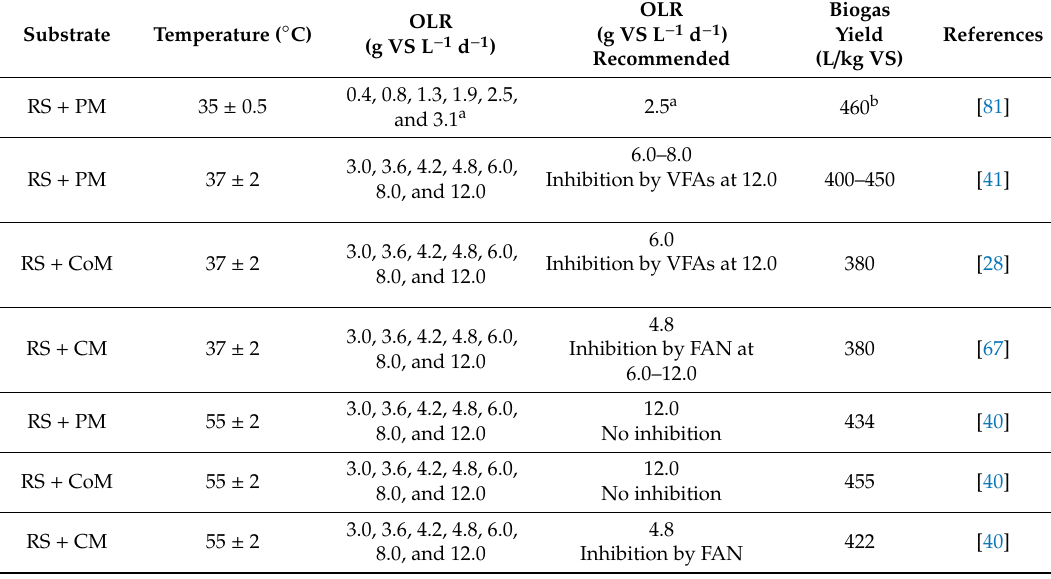
Table 6. E ff ects of OLR on the biogas yield in AD of